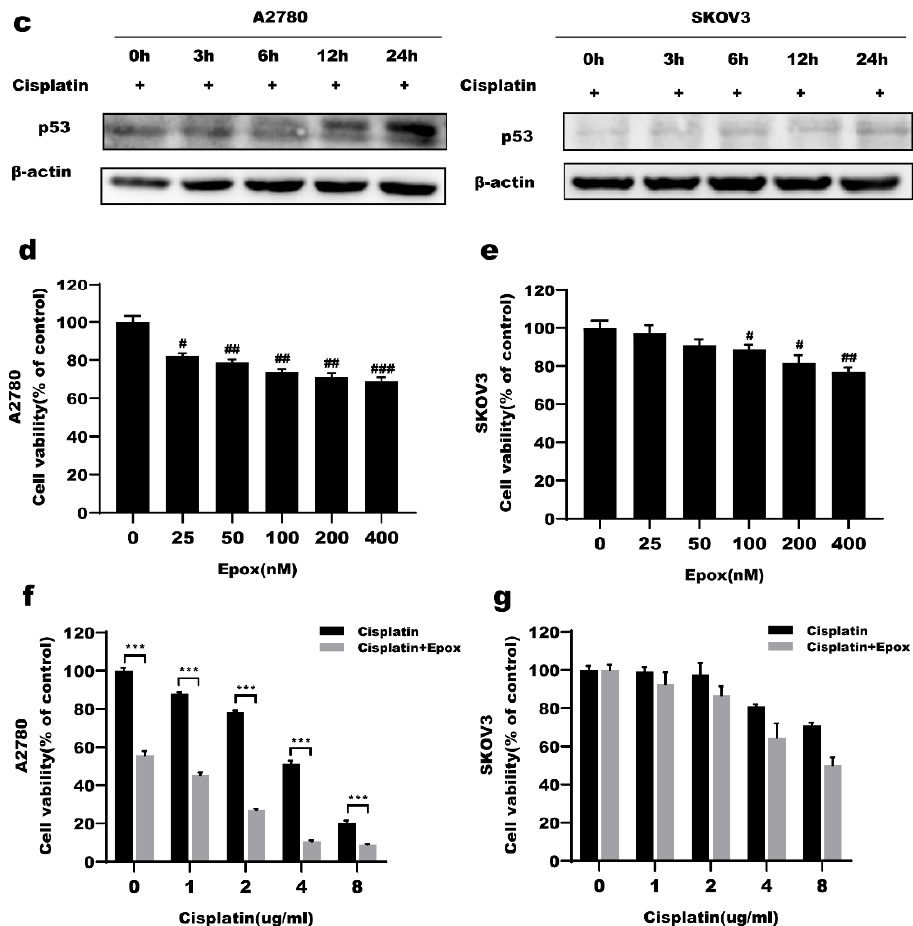
Figure 1. High expression of p53 is related to cisplatin sensitivity of ovarian cancer cells. ( a , b ) Cells were treated with cisplatin for 24 h. The cell viability of A2780 cells and SKOV3 cells were detected by MTT assay. ( c ) p53 protein levels were detected by western blot after treatment with cisplatin (2 µg/mL).( d , e ) Cells were treated with epoxomicin(epox) for 24 h. The cell viability of A2780 cells and SKOV3 cells detected by MTT assay. ( f , g ) Cell viability of A2780 cells and SKOV3 cells were detected by MTT after treated with cisplatin or combined with epox (100 nM) for 24 h. # p < 0.05 vs. con, ## p < 0.01 vs. con, ### p < 0.001 vs. con., *** p < 0.001 vs. Cisplatin.